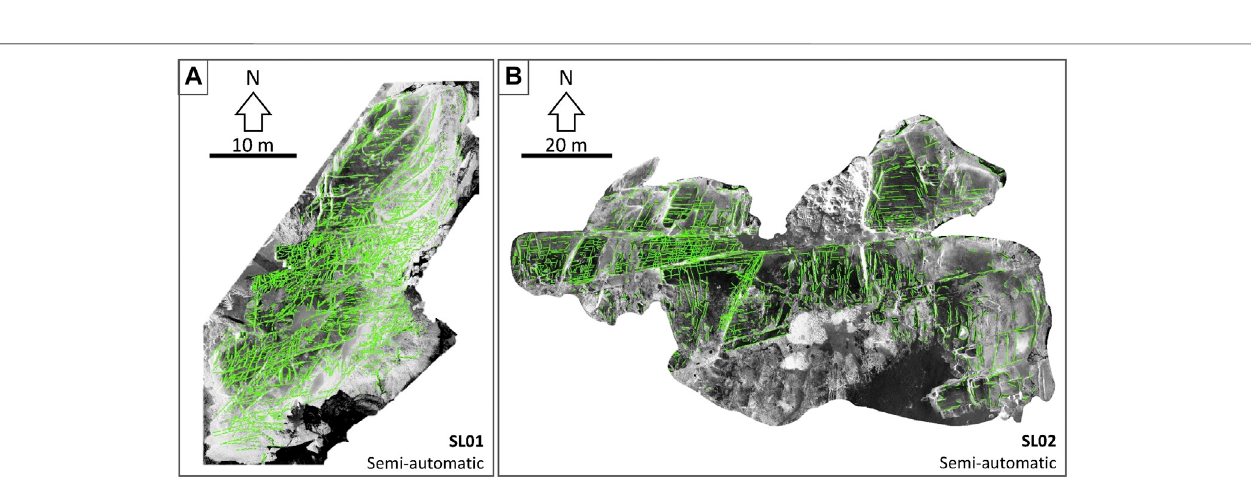
Frontiers in Earth Science |